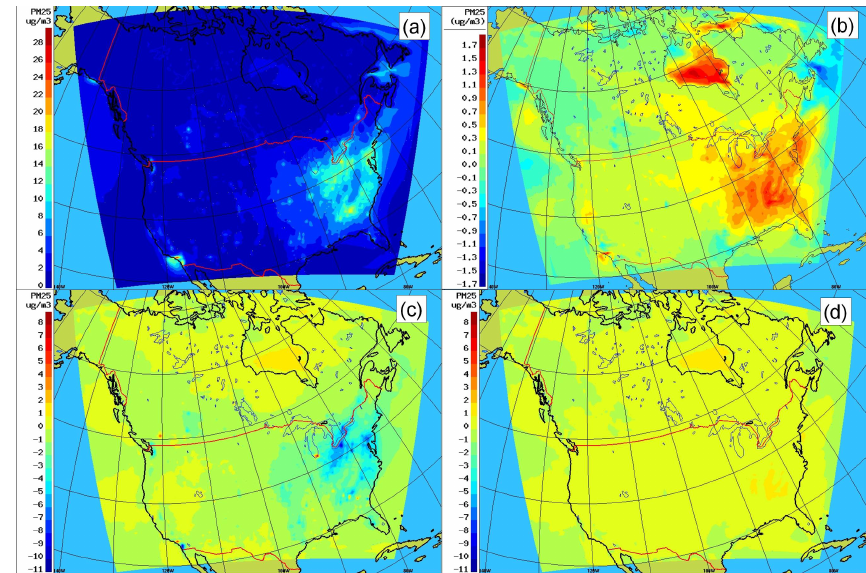
Fig. 8. As in Fig. 7, daily average PM 2 . 5